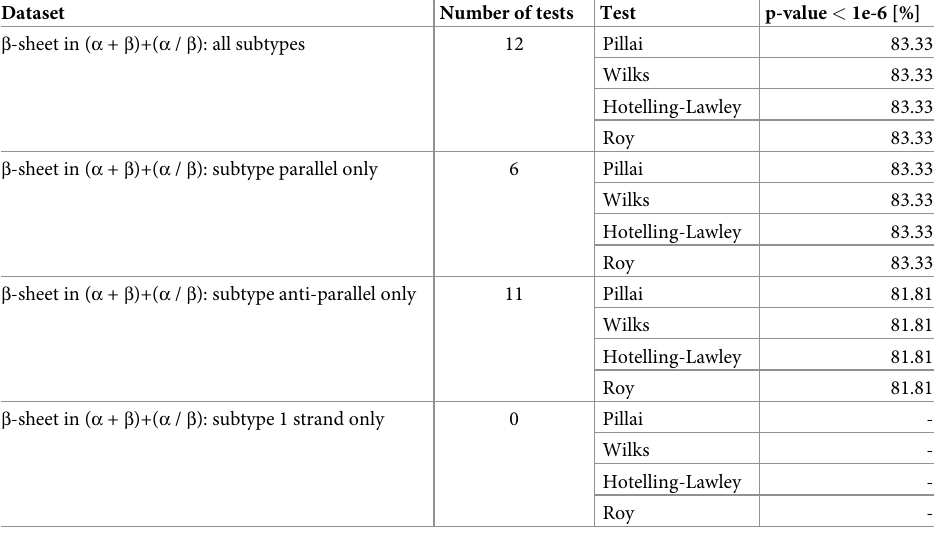
Table 6. Results of the MANOVA test applied to β in the ( α + β ) dataset.